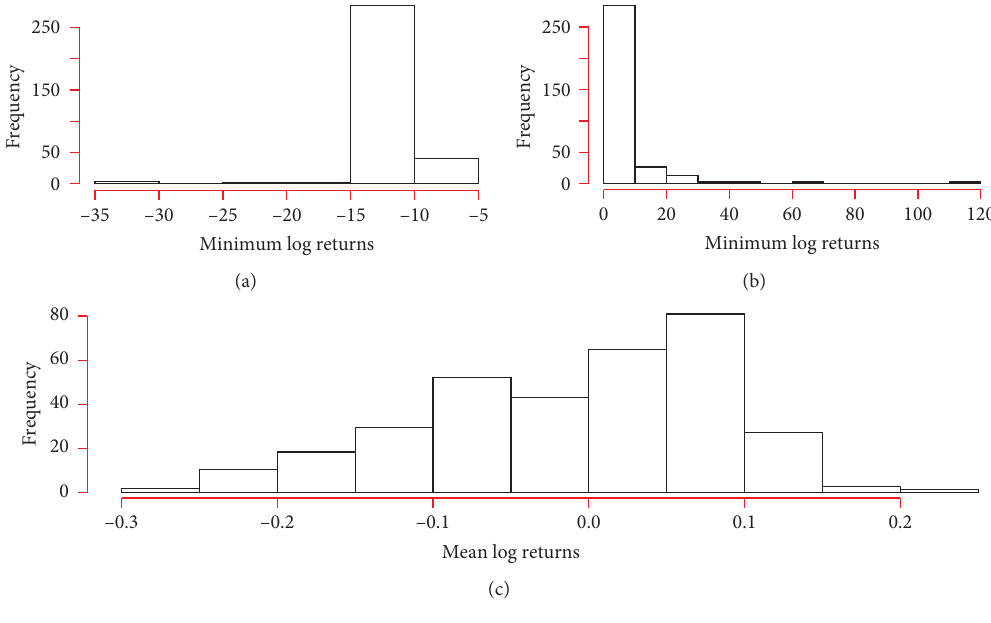
Figure 1: Descriptive statistics of return. Table 1: The 10 stocks with the smallest VaR